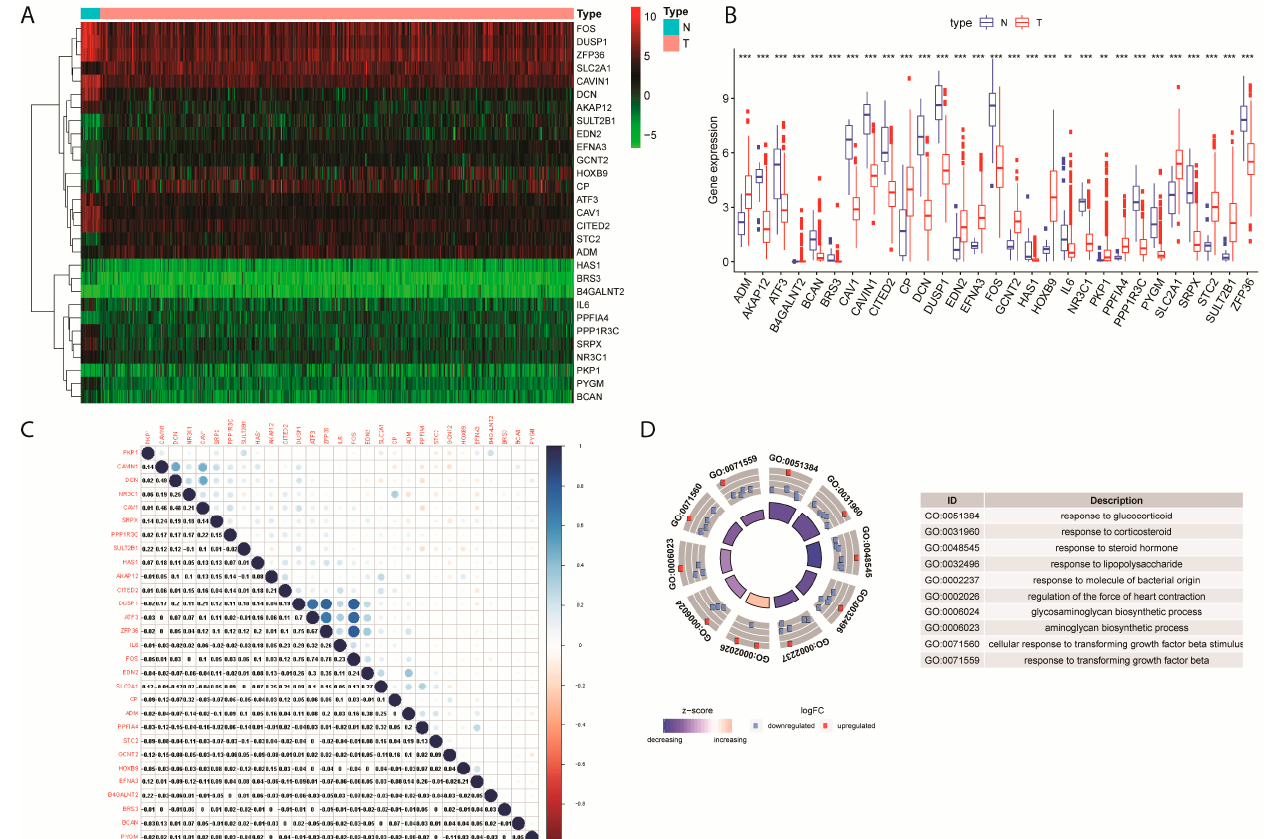
Figure 1. Differential expression profile of hypoxia-related genes in endometrial carcinoma. ( A ) heatmap of differentially expressed hypoxia-related genes clustered in N (Normal) and T (Tumor) cell types. ( B ) Differential expression of hypoxia related genes between N (Normal) and T (Tumor) cell types. ** means p < 0.01, *** means p < 0.001. ( C ) Correlation matrix plot of hypoxia-related differential expressed genes. ( D ) Gene Ontology (GO) Functional Annotation analysis of 29 hypoxia-related DEGs.